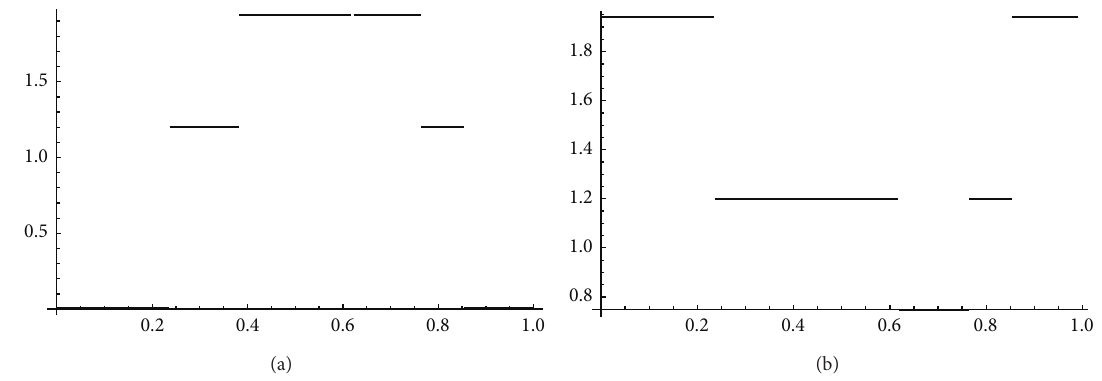
Figure 17: Graphs of invariant measure densities with mask endowment ( 𝑛 = 2 ) (see text): 𝑀 1 = [0,4𝑎 − 1) , 𝑀 2 = [4𝑎 − 1, 1] , 𝑐 = 1.2 (a) and 𝑀